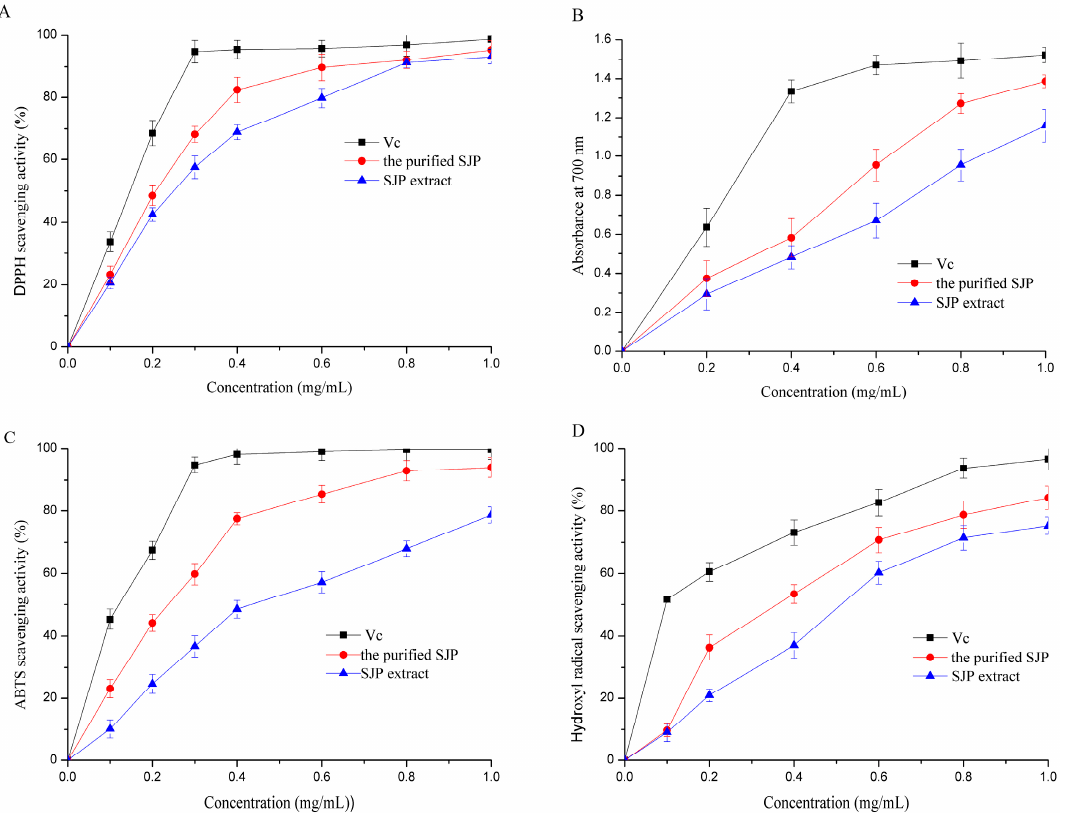
Figure 4. Antioxidant activities of SJP extract, the purified SJP and Vc at different concentrations: ( A ) DPPH radical scavenging activities; ( B ) reducing power activities; ( C ) ABTS radical scavenging activities and ( D ) hydroxyl radical scavenging activities. Each data are presented as the mean value of triplicate measurements.